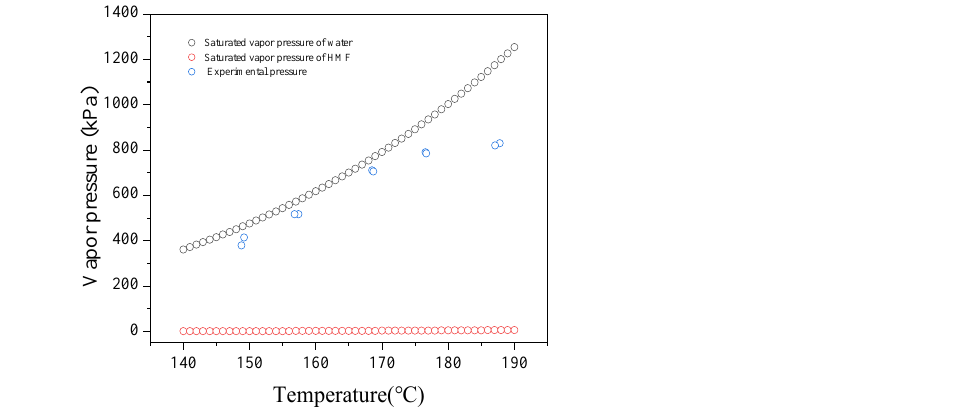
Figure 5. Saturated vapor pressure of water and HMF at different temperatures.